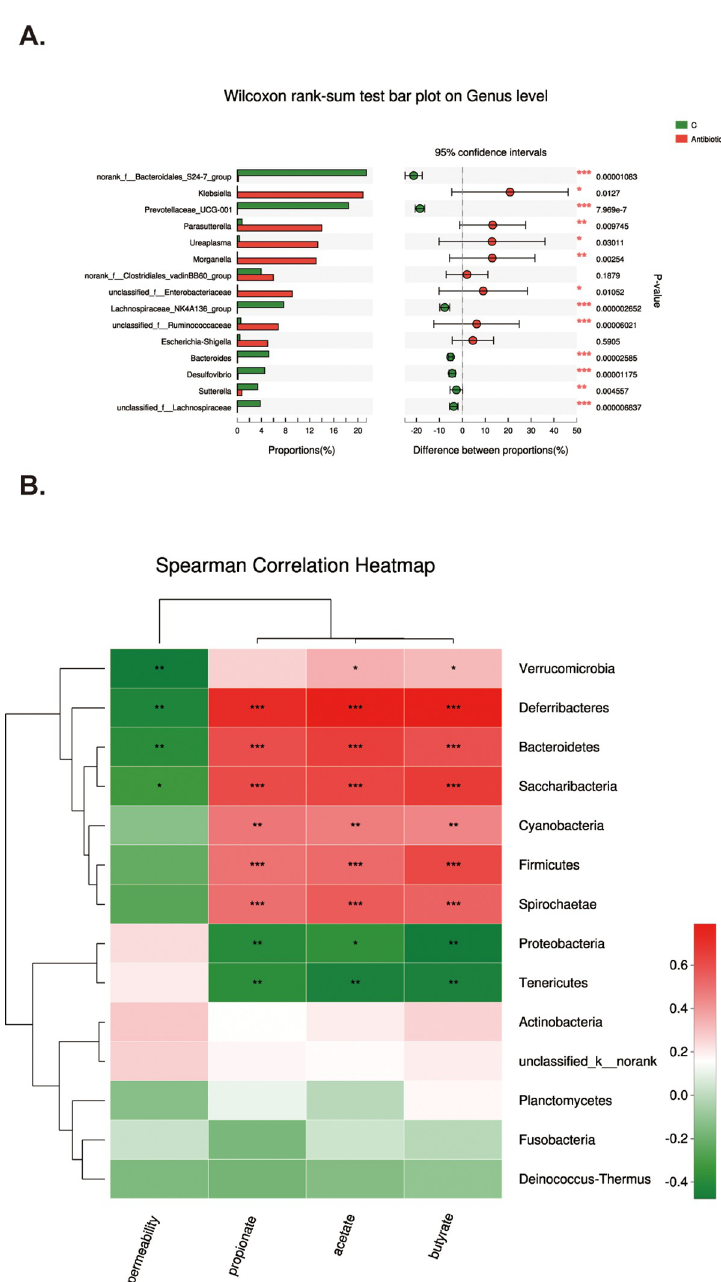
Fig 3. Potential biomarkers and correlation analysis. A. Wilcoxon rank sum test analysis to figure out the potential biomarkers. X axis is percentage value of specific species abundance, and Y axis represents species name at various classification levels. � p < 0.05, �� p < 0.01, ��� p < 0.001 when compared with control group. B. X axis is environmental factors including intestinal permeability, acetate, propionate, and butyrate. Y axis represents specific species on phylum level. Spearman correlation coefficients are represented by color ranging from blue, negative correlation (-0.4), to red, positive correlation (0.6). � p < 0.05, �� p < 0.01, ��� p < 0.001 when compared with control group.